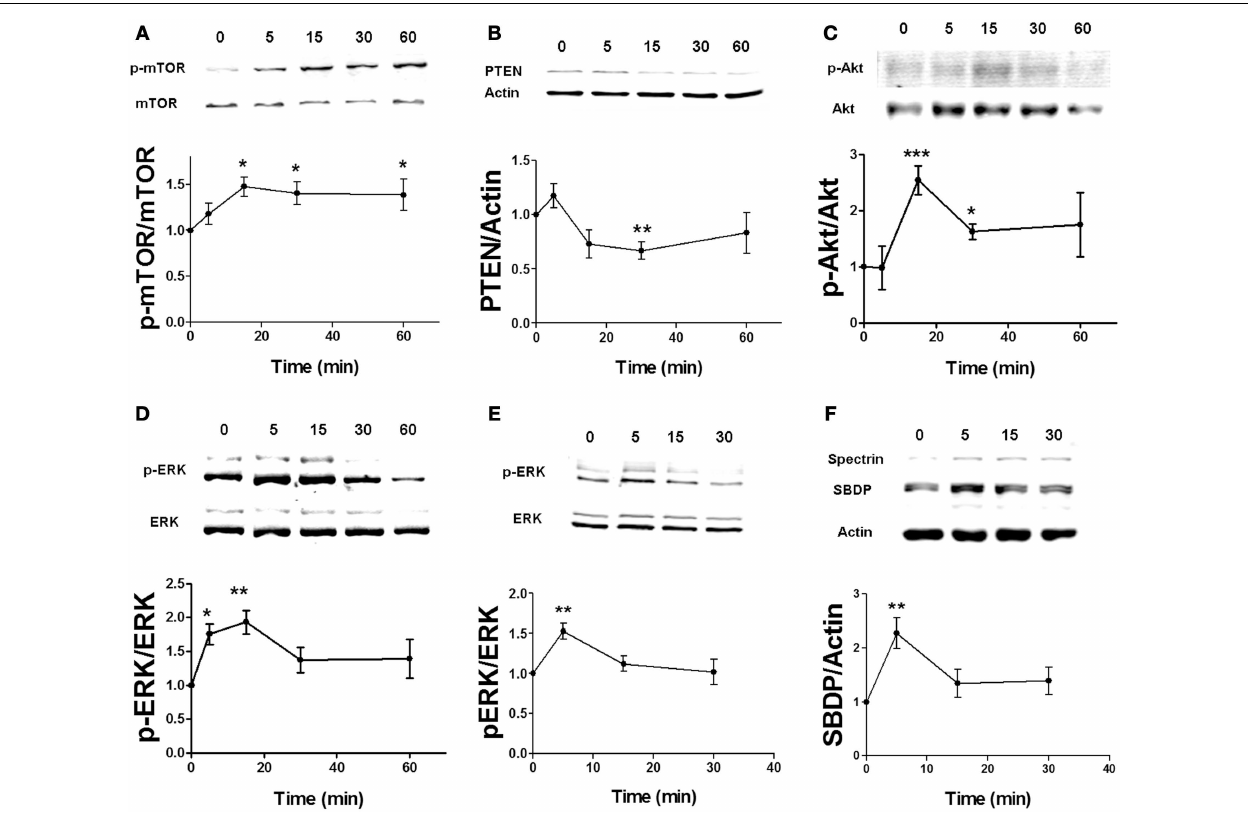
( N = 4–8), (B) PTEN over actin ( N = 3–11), (C) phospho-Akt (p-Akt) over total Akt ( N = 2–8), (D) phospho-ERK (p-ERK) over total ERK ( N = 14–16), (E) p-ERK over total ERK ( N = 4–5), (F) spectrin breakdown product (SBDP) over actin ( N = 3–5); * p < 0.05, ** p < 0.01, *** p < 0.001, as compared to control (0min) (one-way